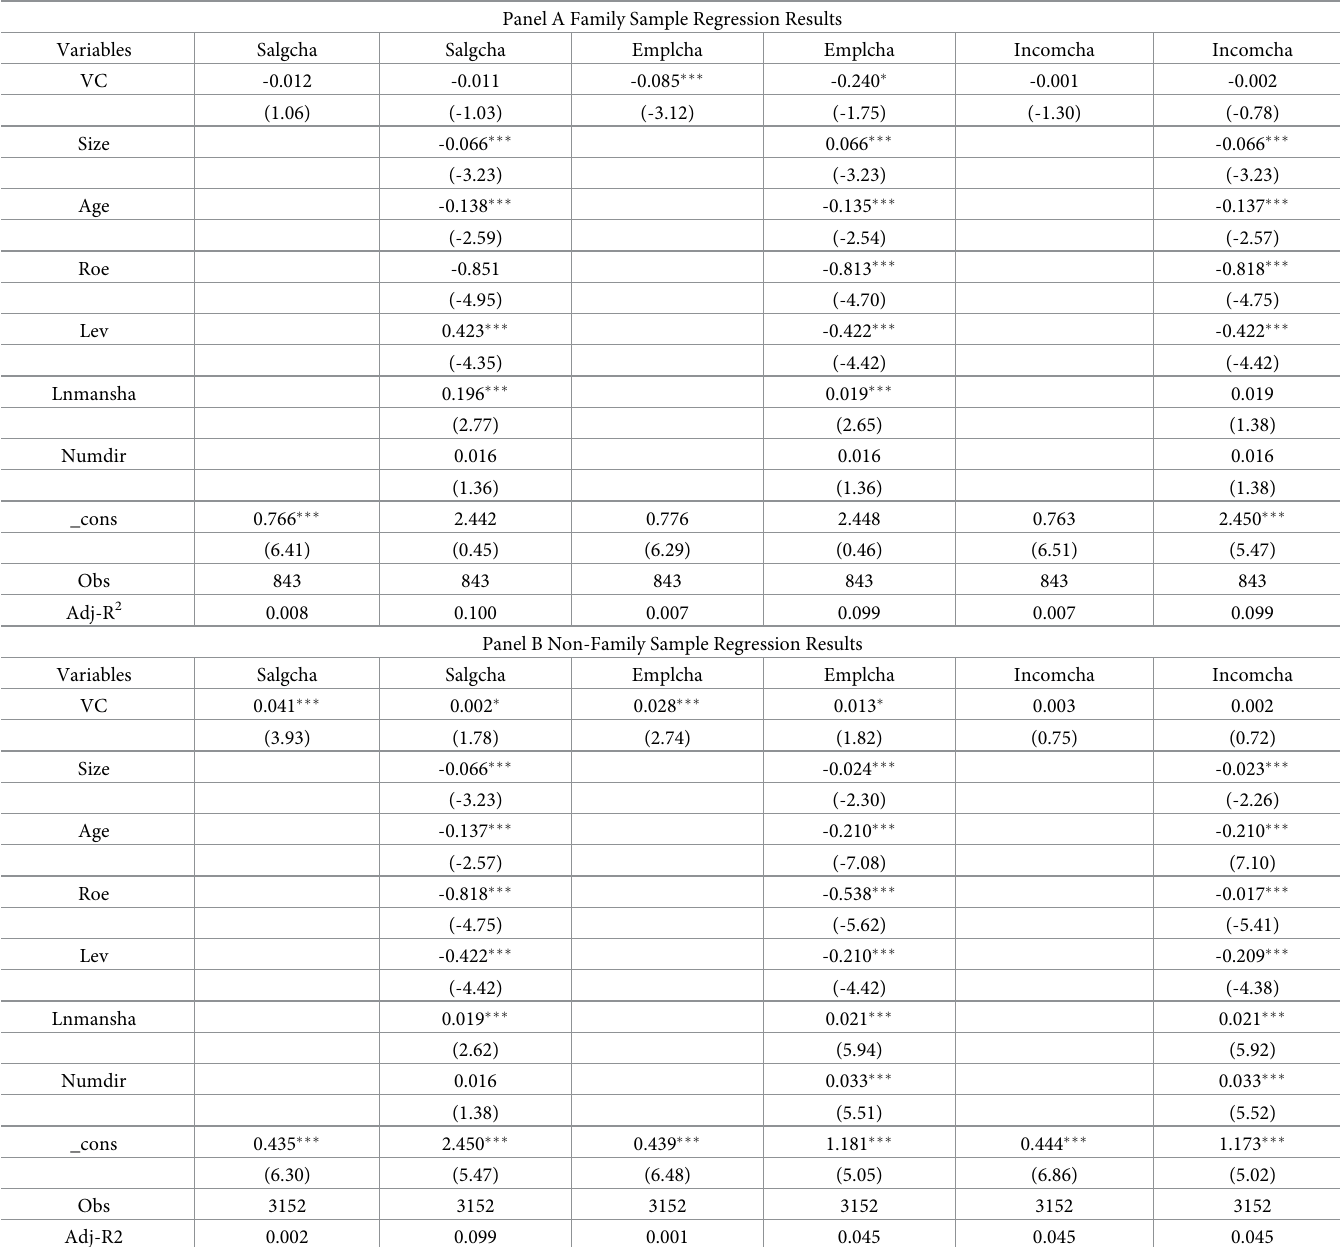
Table 2. Regression test of venture capital effect on family enterprise growth